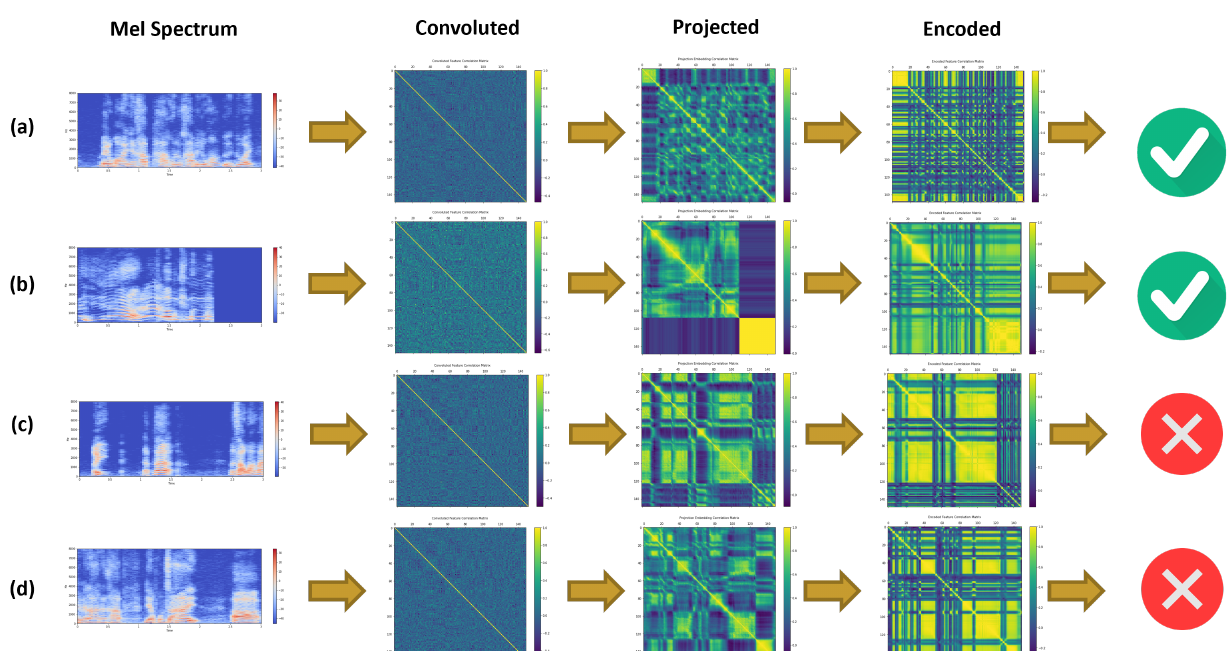
Figure 10. Correlation coefficients of E2ESER-CD using fine-training of XLSR with the LMET back- end network based on the ThaiSER dataset: ( a ) normal speech chunk; ( b ) chunk containing normal silence; ( c ) chunk containing mostly silence; and ( d ) chunk between speech. Note that the correct (green circle) and incorrect (red circle) signs are model results when compared with emotion labels. Please see the full resolution image in the supplementary